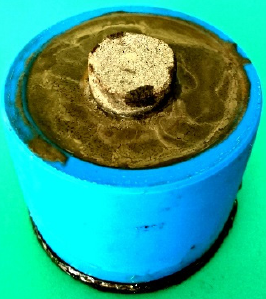
Figure 4. Sandstone core with cement slurry prepared for adhesion tests on the contact surface between the core and cement.